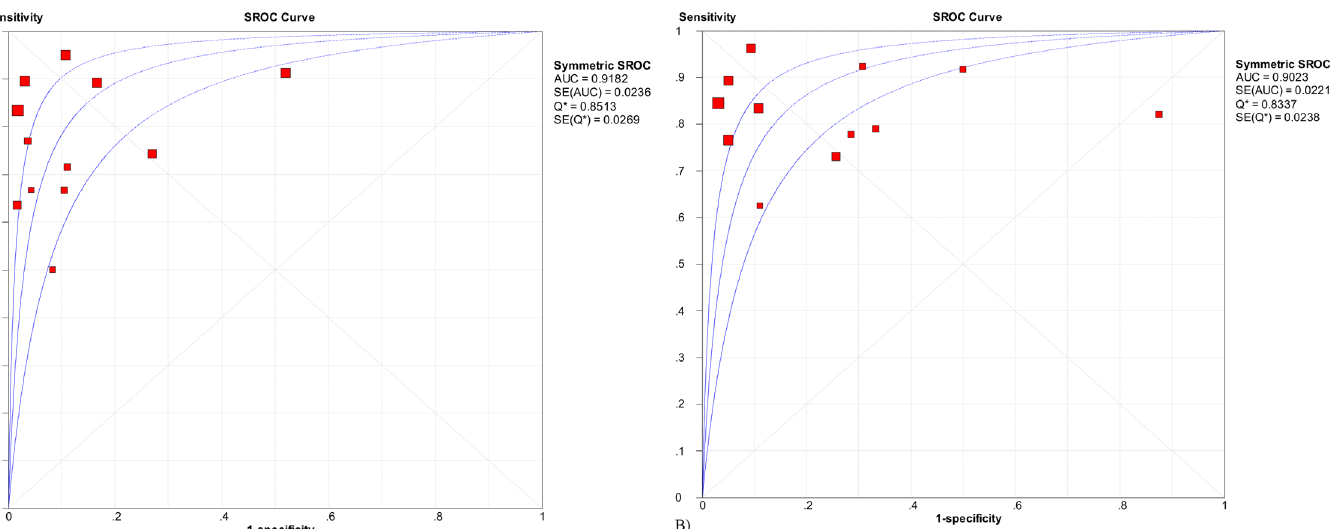
PLOS ONE | DOI:10.1371/journal.pone.0158373 July 7,